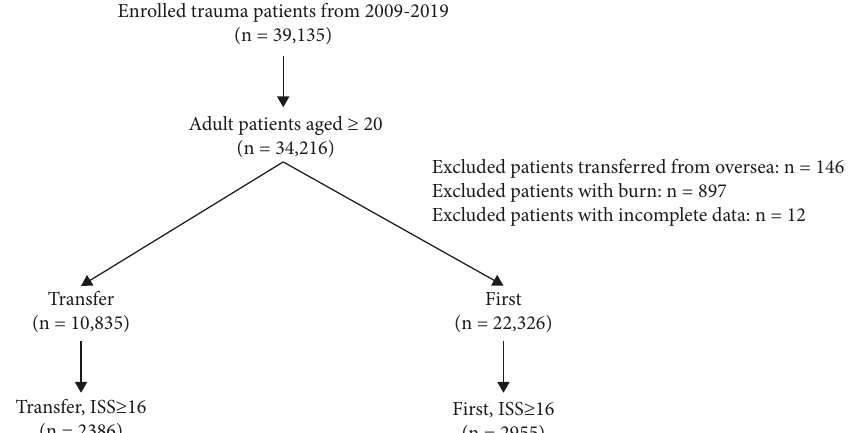
Figure 1: Flowchart illustrating the inclusion of adult patients with major trauma from the Trauma Registry System, with the allocation of these patients into transfer (transferred patients) and direct groups (visited the hospital